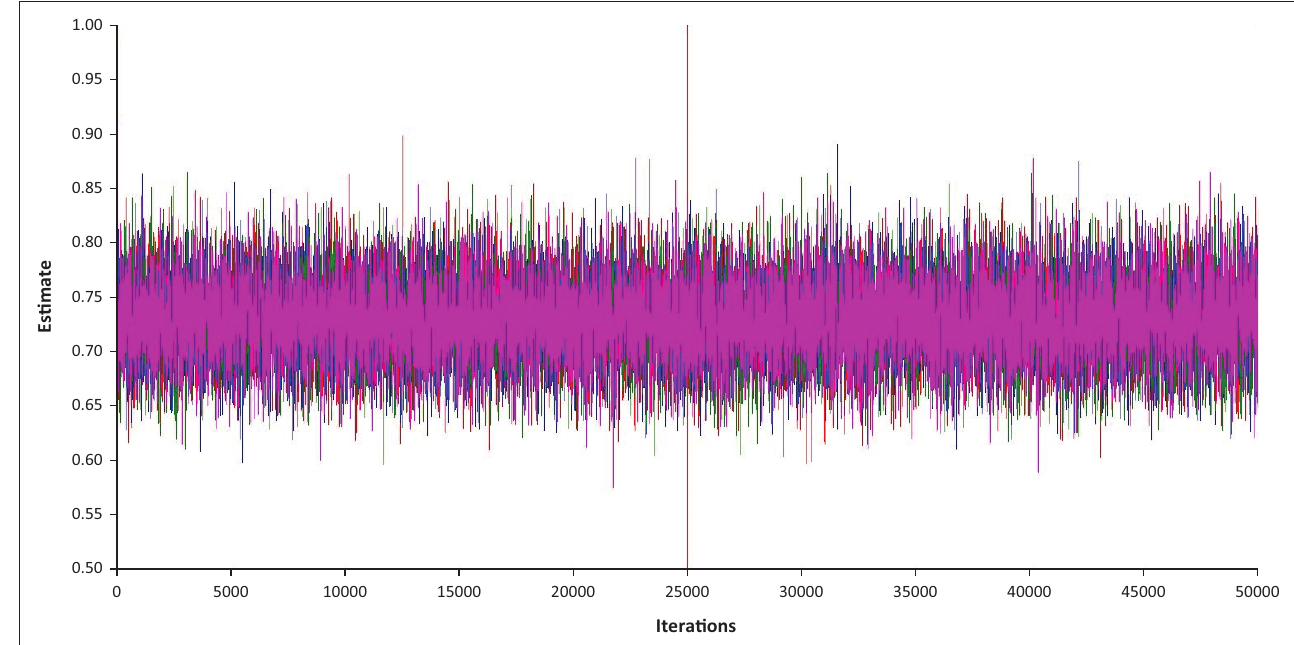
FIGURE 2: The trace plot and parameter loading for item p1 on the 1-factor(Fact) model (use colour in print).